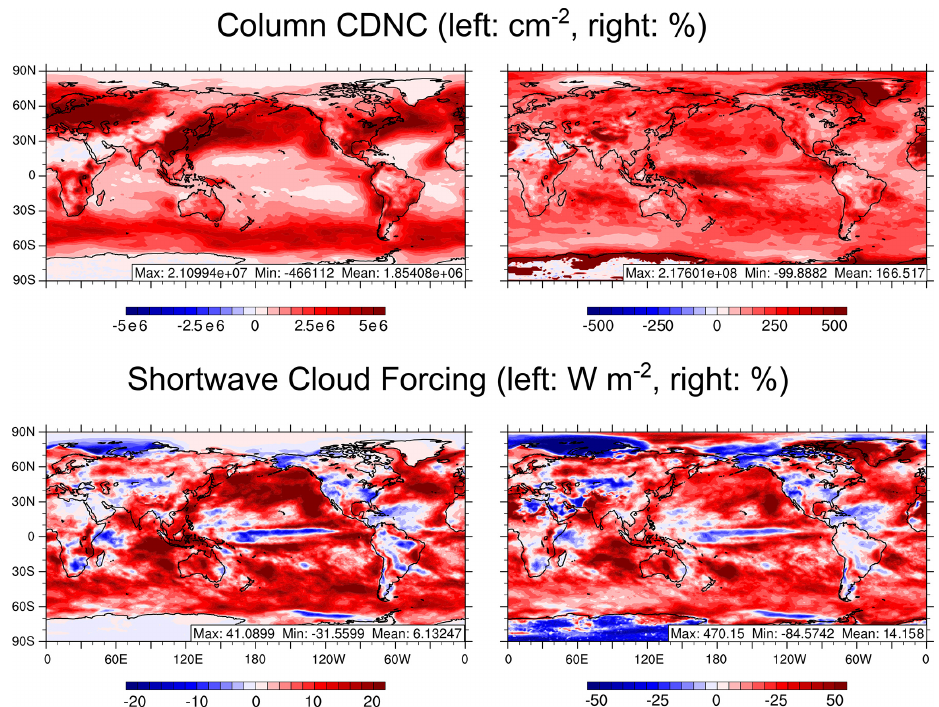
Figure 4. Annual-average absolute and percentage changes from the FN05 and AR-G00 CESM/CAM5 simulations for column CDNC and shortwave cloud forcing. Because the shortwave cloud forcing typically has negative values, the absolute change map (bottom left) uses |SWCF|so that the warmer colors represent an increase in the forcing even though they are more negative values. The global mean percentage change values are calculated from the averaged absolute change rather than the average of the gridded percentage